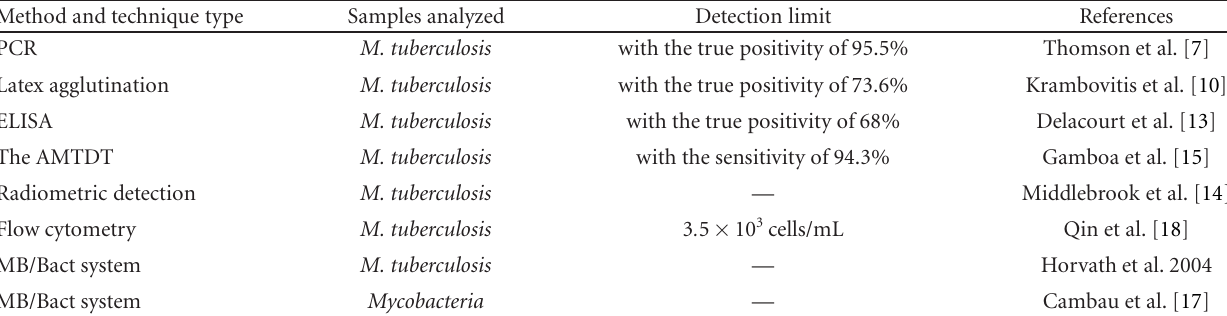
Table 1: The various mentioned non-biosensing techniques for bacteria